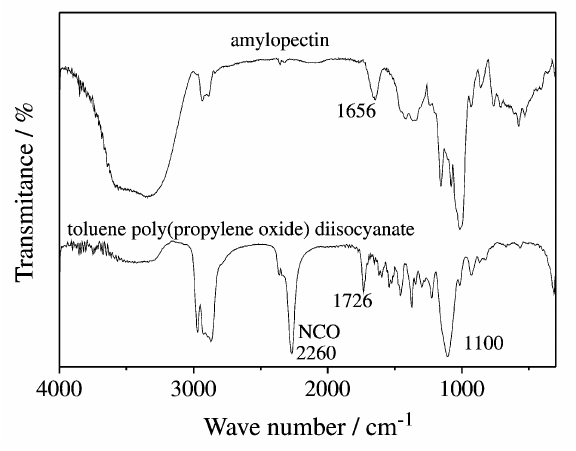
Figure 1. FTIR spectra of the amylopectin-rich starch and toluene poly(propylene oxide)